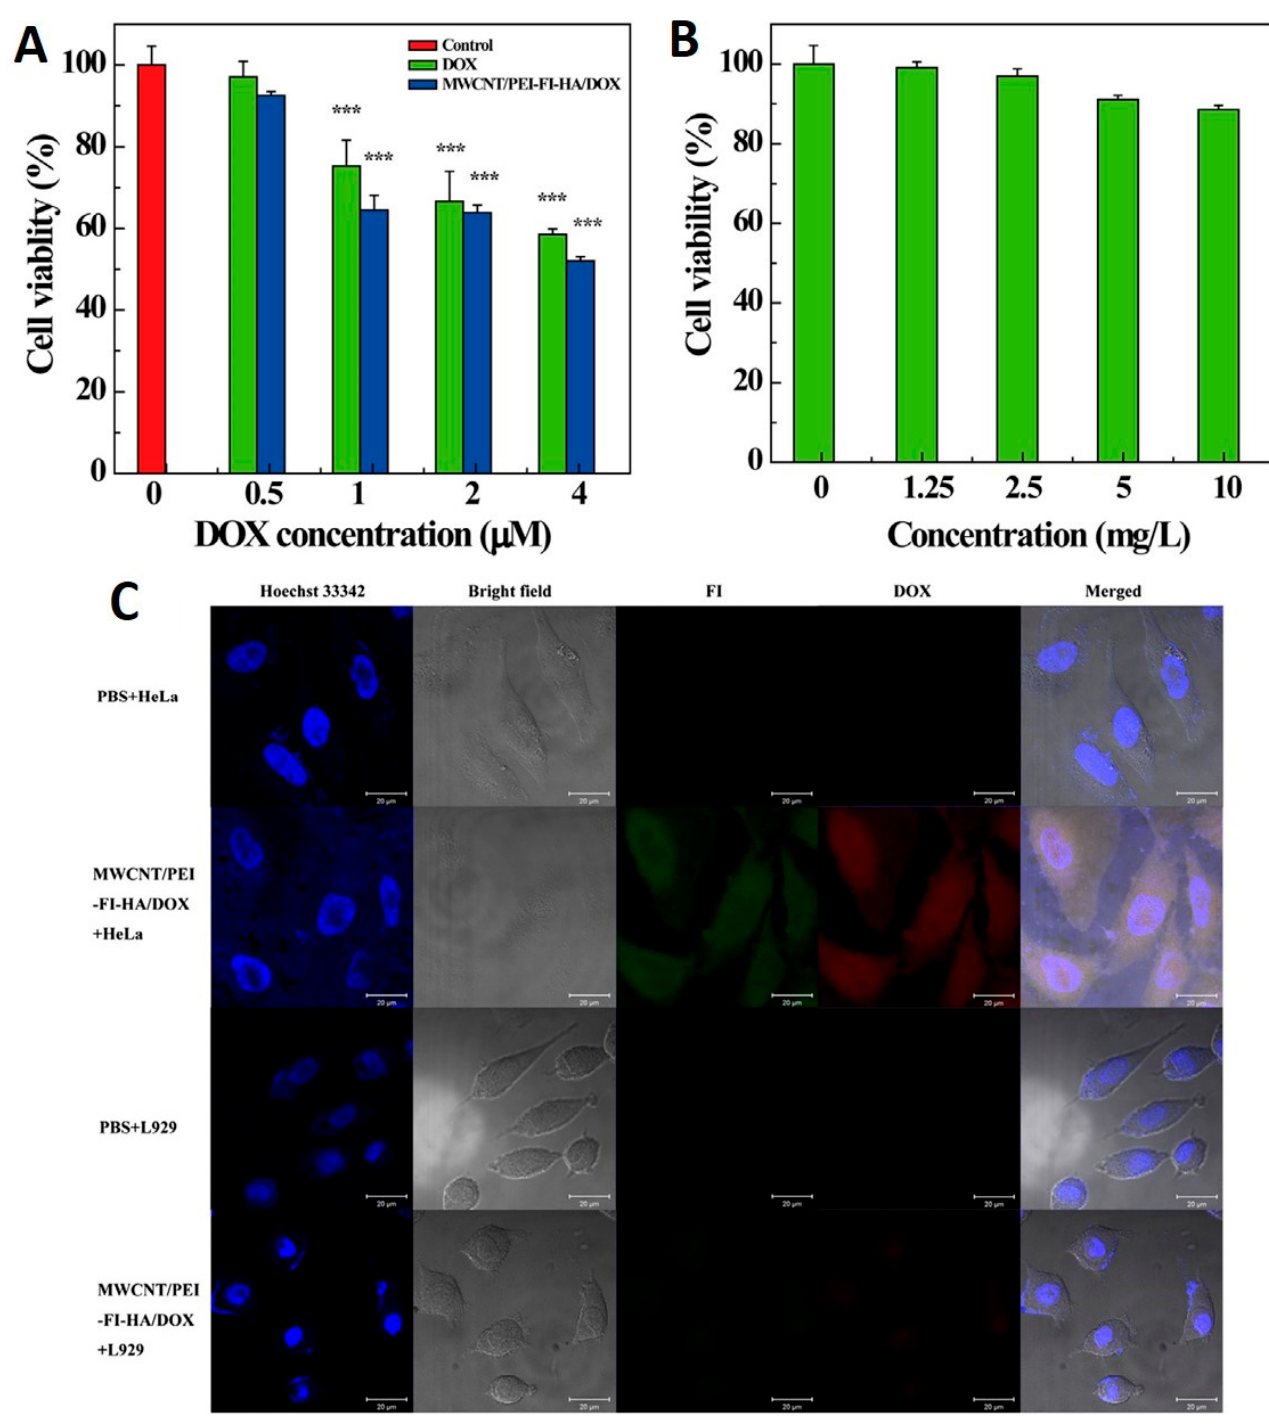
Figure 10. ( A ) MTT viability assay of HeLa cells treated with free DOX and MWCNT/PEI–FI– HA/DOX complexes at the DOX concentrations of 0–4 μ M for 24 h, and ( B ) DOX-free MWCNT/PEI– FI–HA at corresponding DOX concentrations of the complexes between 1.25 and 10 mg/L. ( C ) Confocal microscopic images of HeLa and L929 cells treated with MWCNT/PEI–FI–HA/DOX complexes ([DOX] = 2 μ M) for 2 h. HeLa and L929 cells treated with PBS were used as controls. The scale bar in each panel represents 20 μ m. Reprinted with permission from Carbohydrate Research, Copyright 2015, Elsevier [78]. *** represents the significant level p < 0.001.